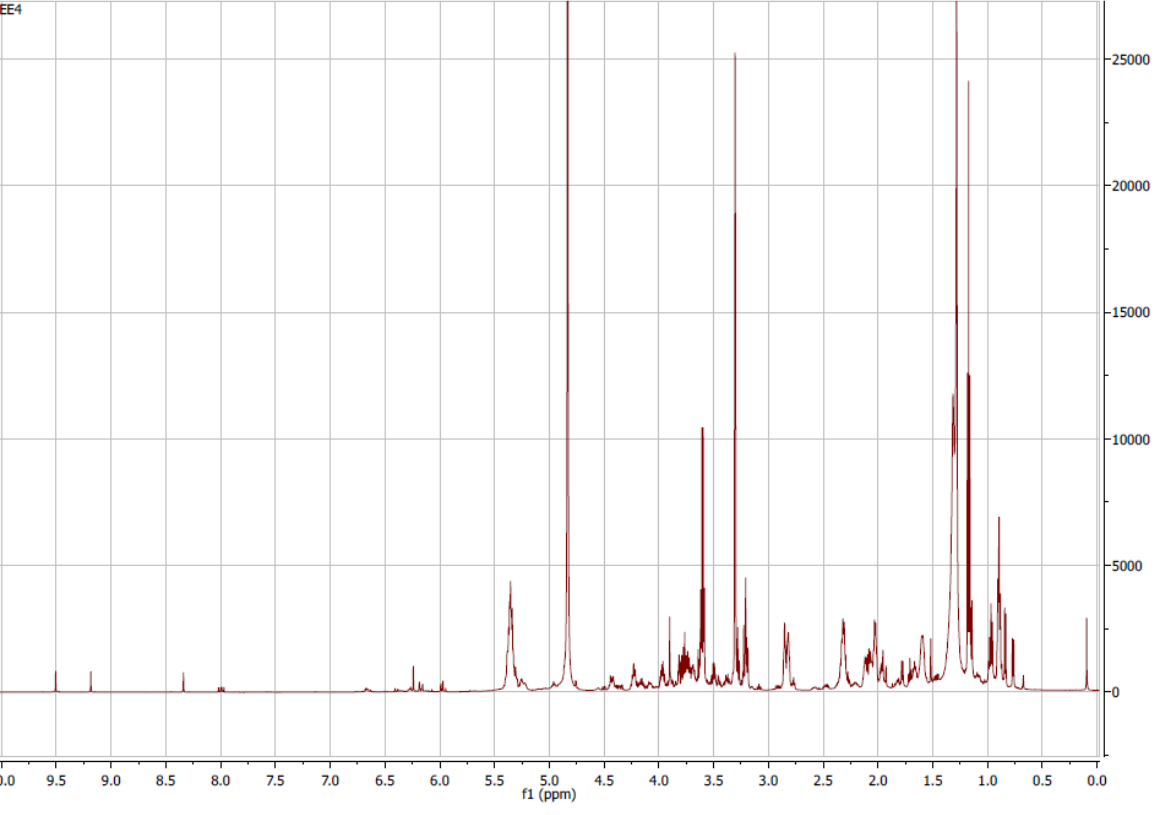
Figure 3. 1 H NMR spectrum (600.13 MHz) of N. oculata ethanolic extract metabolites in CD 3 OD.